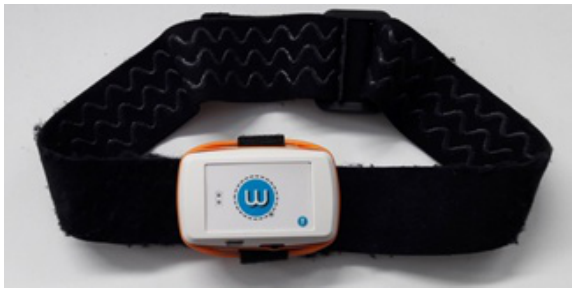
Figure 4. Sensor with the forehead